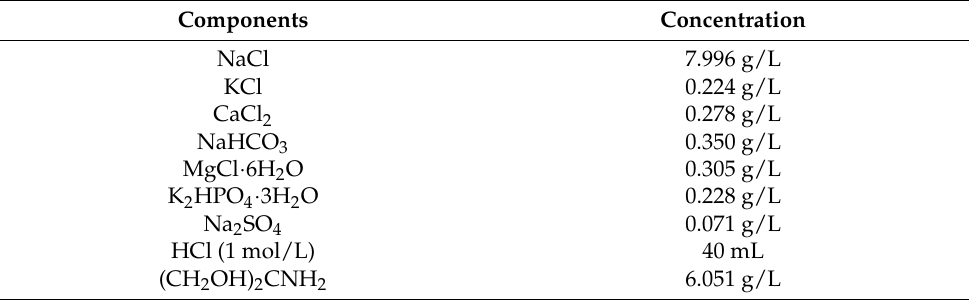
Table 2. The chemical compositions of